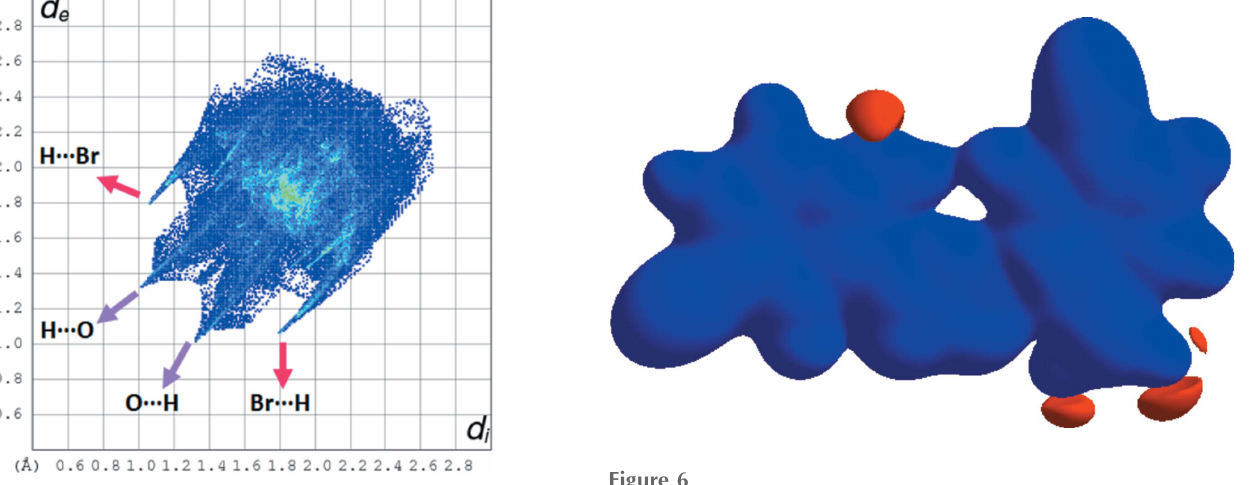
Figure 6 A view of the three-dimensional Hirshfeld surface of the title compound plotted over electrostatic potential.